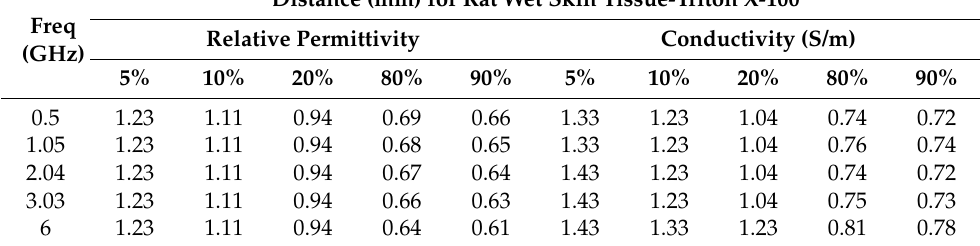
Table 8. Specified increase levels for retrieved relative permittivity and conductivity of double- layered rat wet skin tissue and triton X-100 configuration and the corresponding distances (D n ) at 0.5, 1.05, 2.04, 3.03 and 6 GHz frequency points.